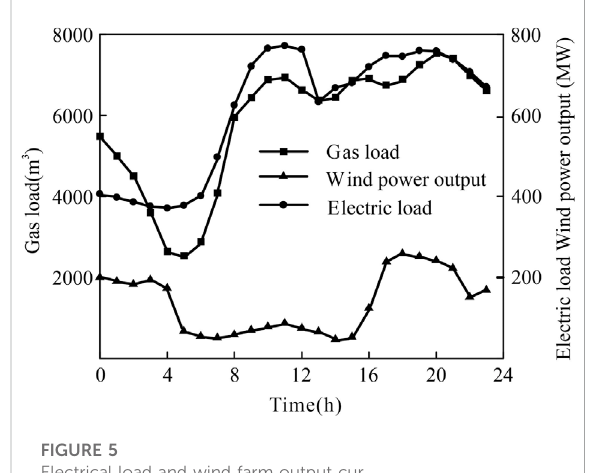
FIGURE 5 Electrical load and wind farm output cur.